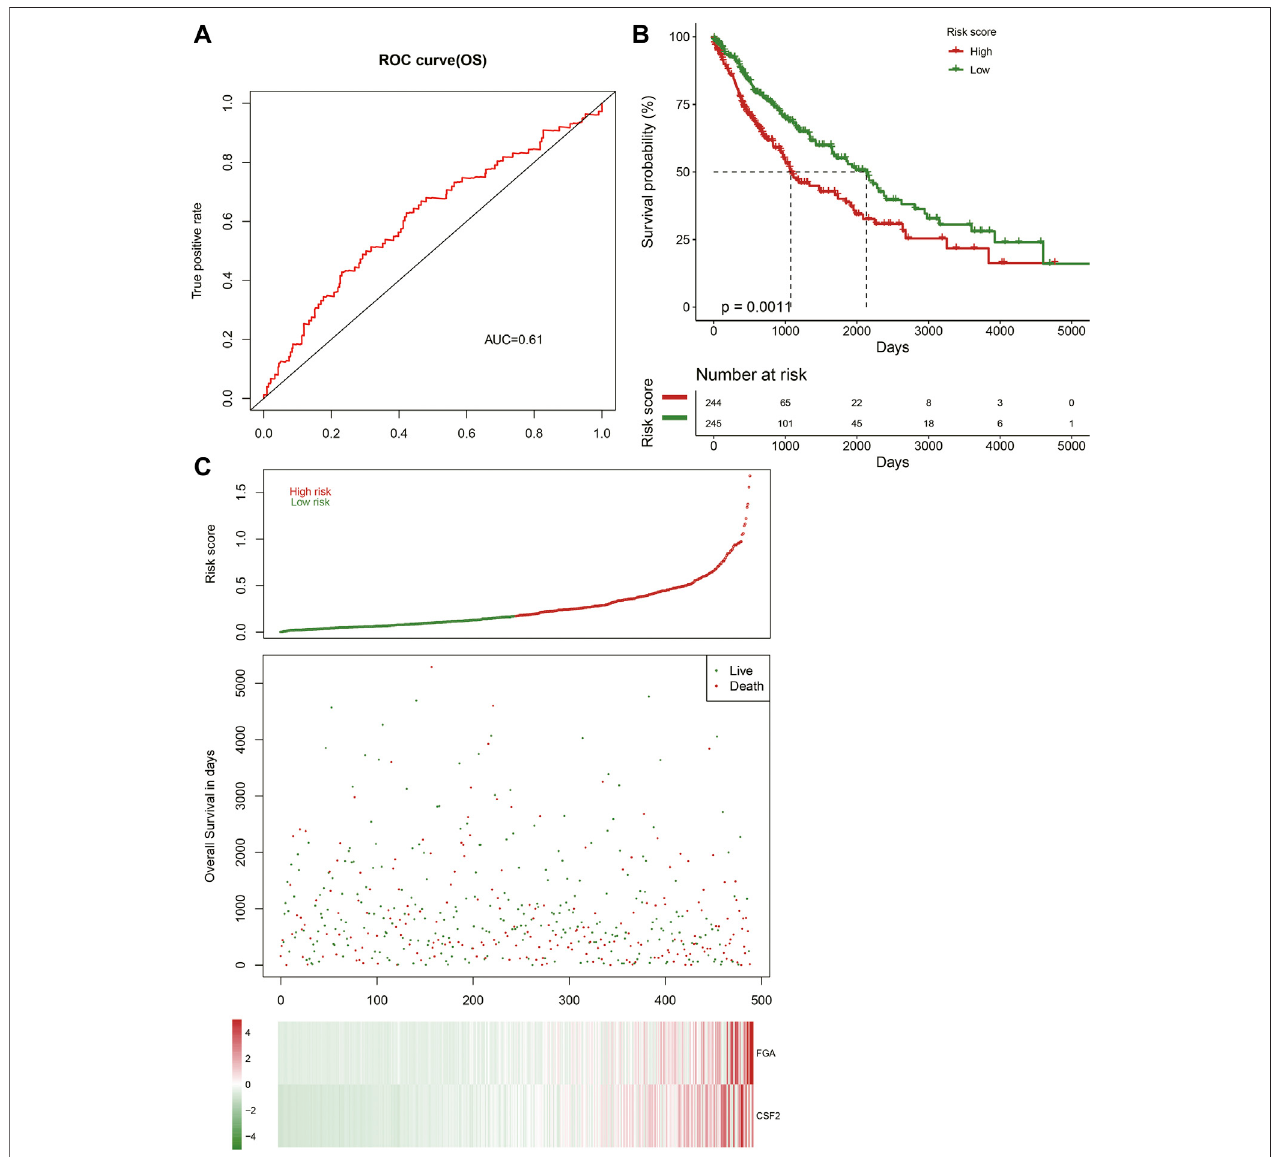
FIGURE7| Constructionoftheprognosticmodel. (A) Receiveroperatingcharacteristic(ROC)curveshowingtheprognosticvalueoftherisksignature. (B) Patients in the high-risk group demonstrate shorter overall survival. (C) Survival conditions of LUSC patients.